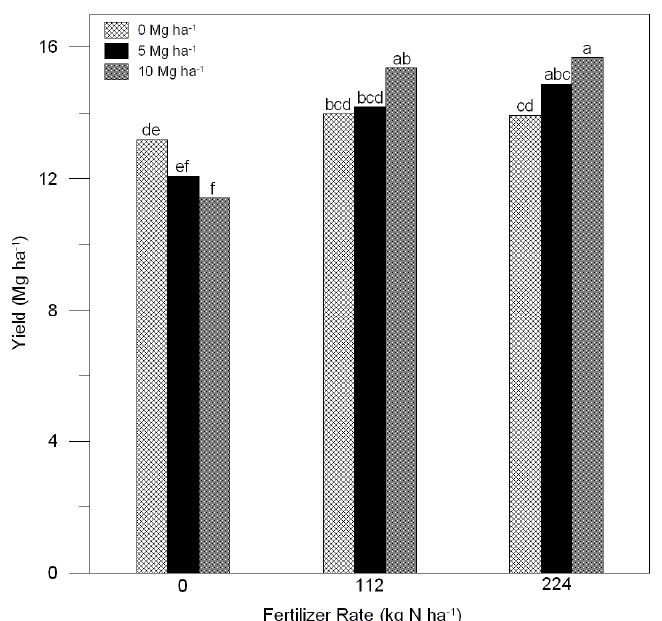
Figure 3. Corn yield as influenced by pine woodchip biochar and fertilizer rates. The fertilizer rates are 0, 112, and 224 kg·nitrogen (N)·ha − 1 rates. The biochar treatments are displayed in the shaded boxes at rates of 0, 5, and 10 Mg·ha − 1 . Bars with different letters are statistically different from each other ( p <